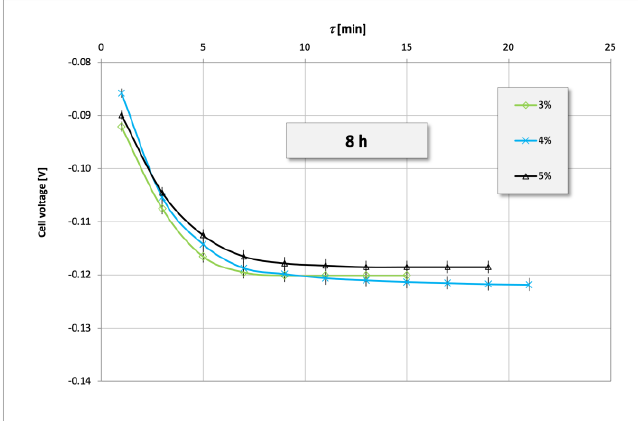
Figure 5. Cu-Ag cathode oxidized for 8 h — the electroless potential of cathode.